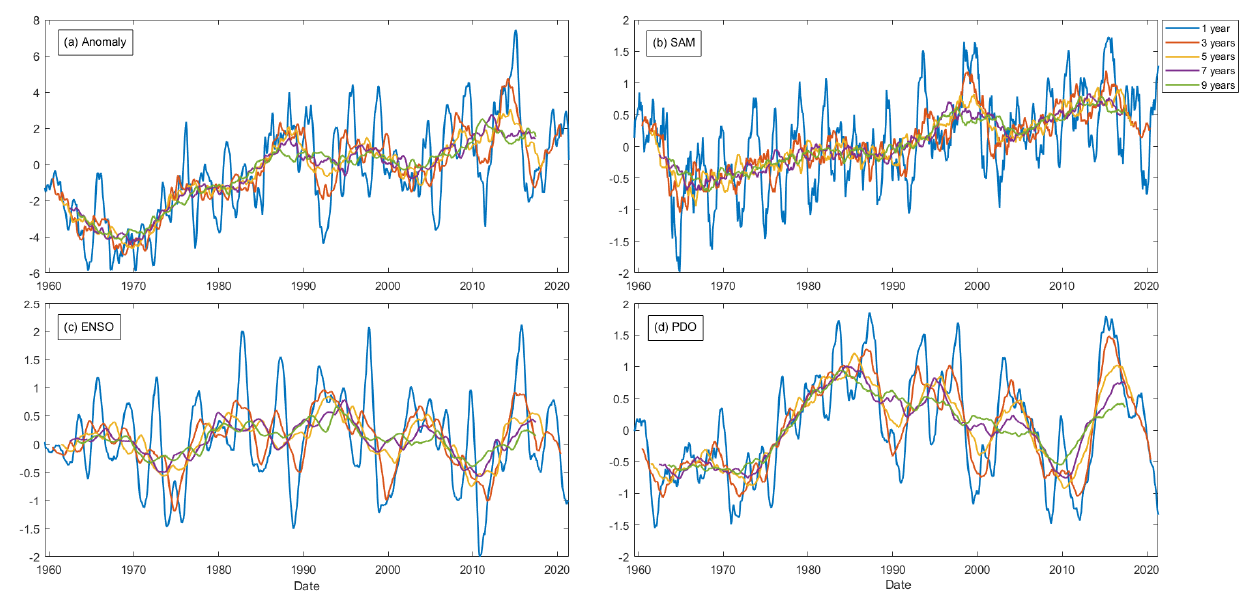
Figure 2. Temporal evolution of the: ( a ) anomalies of strong winds (for the unit, see Section 2.2), ( b ) SAM, ( c ) ENSO, ( d ) PDO.